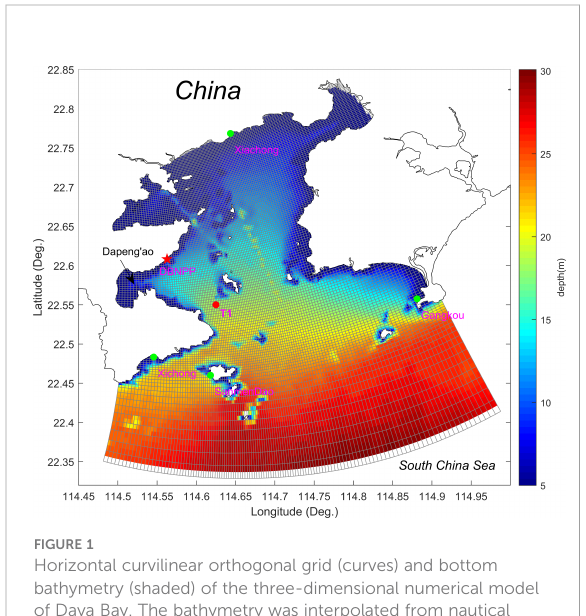
FIGURE 1 Horizontal curvilinear orthogonal grid (curves) and bottom bathymetry (shaded) of the three-dimensional numerical model of Daya Bay. The bathymetry was interpolated from nautical charts. Red star indicates the position of the Daya Bay Nuclear Power Plant (DBNPP). Green dots demonstrate the four tidal gauge stations (i.e., Gangkou, SanmenDao, Xiachong, and Xichong). Red dot illustrates the T1 station with temperature observations